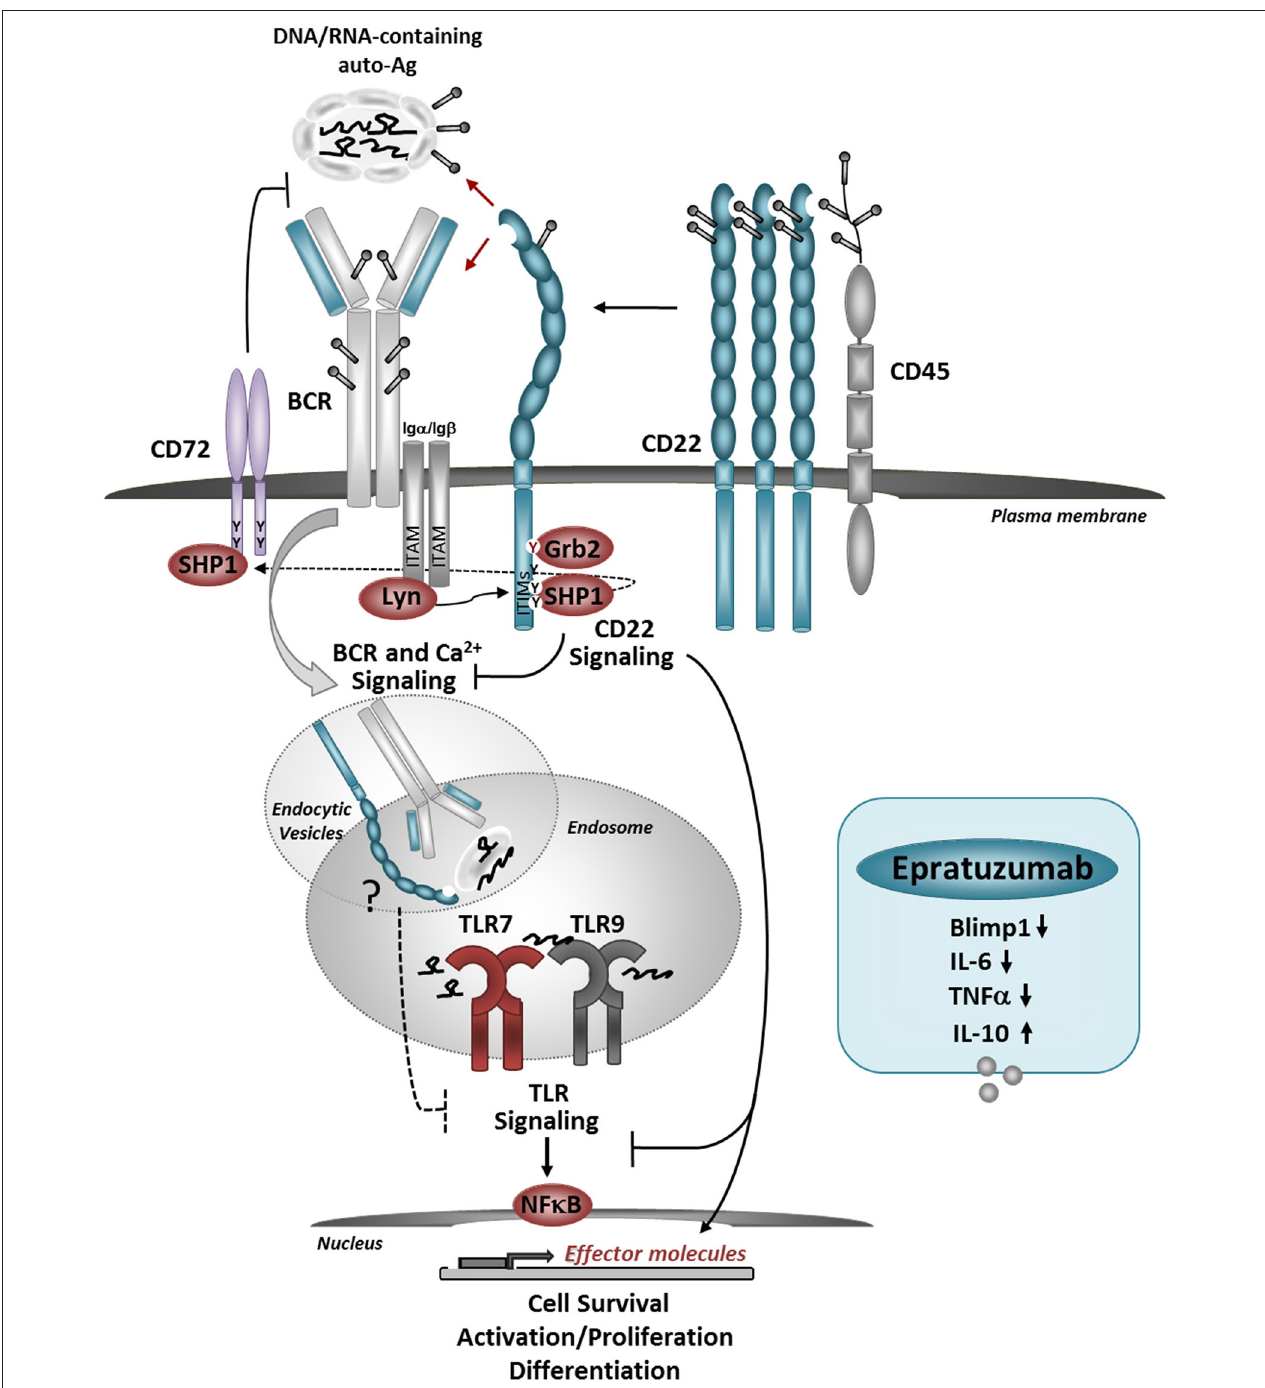
FIGURE 1 | Model for the role of CD22 in regulating BCR/TLR-mediated B cell responses to autoantigens. CD22 molecules are organized in nanodomains, regulated by interactions with CD45. Self-Ags, decorated with sialylated ligands may recruit CD22 molecules close to the BCR, upon which CD22-SHP-1 activation inhibits downstream signaling. The uptake up of nuclear-containing Ags triggers TLR7 and TLR9 activation in the endosomes. CD22 may inhibit TLRs activation via several mechanisms: promoting the activation of CD72, direct inhibition of TLR signaling after internalization, and/or affecting the expression and activation of NF- κ B and pro-survival pathways. Crosslinking of CD22 with a therapeutic antibody Epratuzumab, inhibits the expression of Blimp1 and pro-inflammatory cytokines in response to TLRs stimulation. Antibody-mediated CD22 ligation induces internalization of CD22, SHP-1, and Grb2 activation and may also promote co-localization with TLRs in the